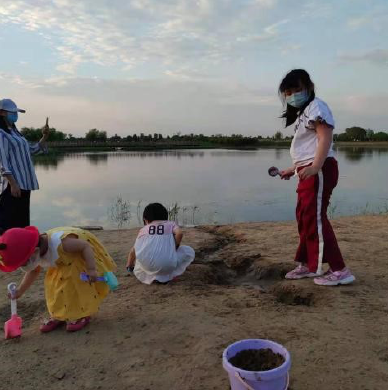
Fig. 2 Monotonous waterfront space dissatisfies children’s needs for